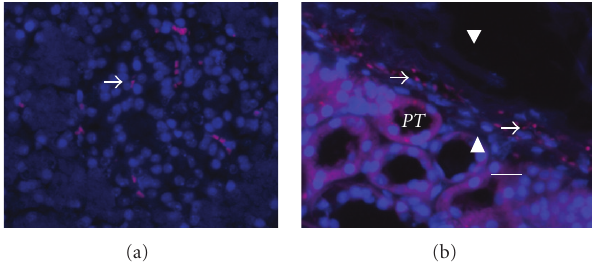
Figure 2: Fluorescence microscopy of tissue sections originating from (a) a normal porcine pancreas or (b) a subcapsular section from a kidney of a rhesus macaque transplanted with embryonic pig pancreas in mesentery and subsequently with porcine islets in that kidney. PT : proximal tubule, arrows: delineate pig X chromosomes. Arrowheads: renal capsule (b). Scale bar 10 um. Reproduced with permission from Organogenesis [8].